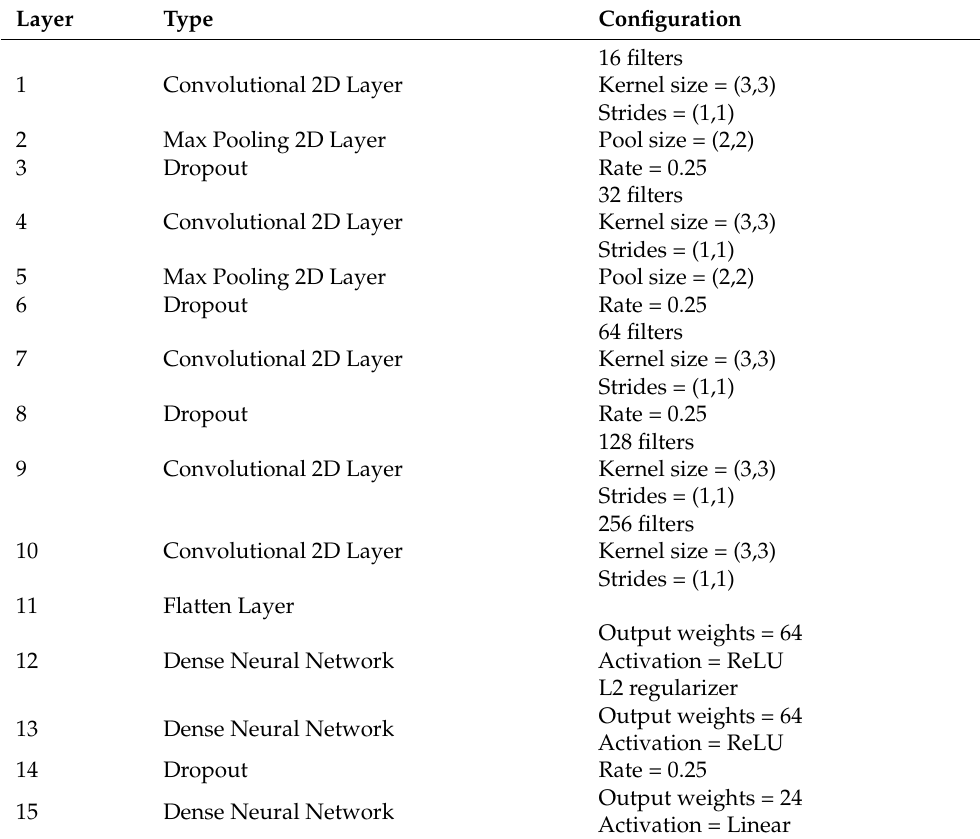
Table 2. The architecture and hyper-parameters of the CNN model for reverberation level